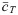
a) Solutions for cytosolic calcium concentration, ci, as a function of total calcium concentration, c¯T. Discontinuous lines represent unstable solutions and continuous lines stable ones. A closer look at the transitions is shown in b). When reducing the total concentration, at c¯T≈66μM, a limit cycle emerges in a Hopf bifurcation, from the upper state, that then becomes unstable. The red lines represent the lower and upper values of the limit cycle. At, c¯T≈50μM, the intermediate unstable fixed point collides with the limit cycle, that disappears in a homoclinic bifurcation. Below c¯T≈39μM, the RyR close state is the only solution. c) Oscillation periods as a function of c¯T.